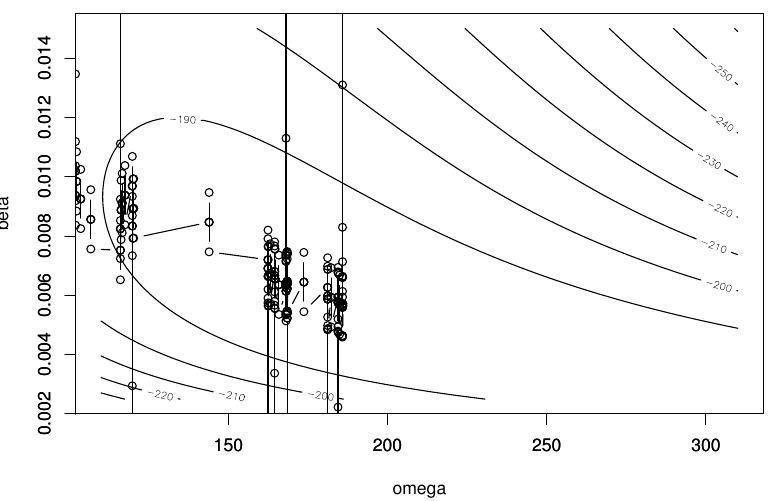
Figure 2. Trace of parameters in the Nelder–Mead method.